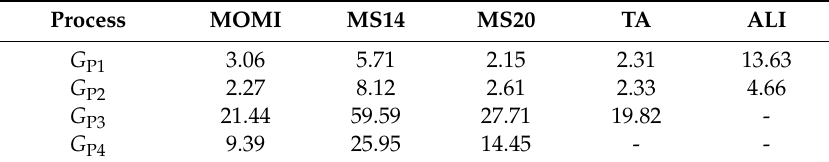
Table 4. ITSE criterion values for reference tracking.